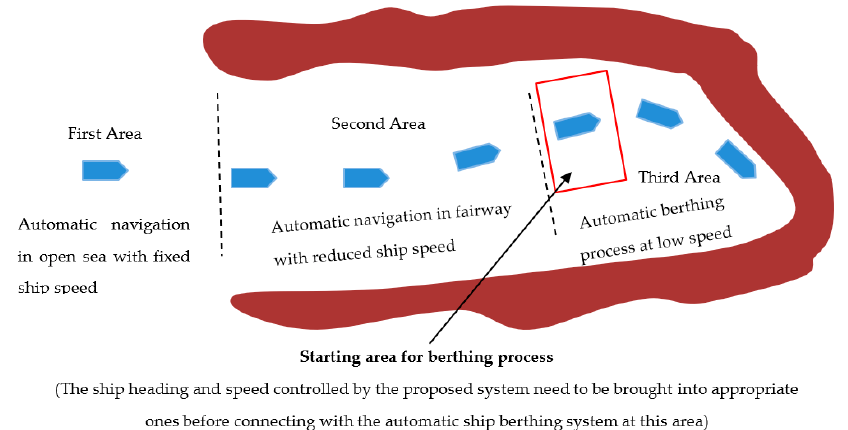
Figure 1. Automatic navigation system of a ship in a fairway.